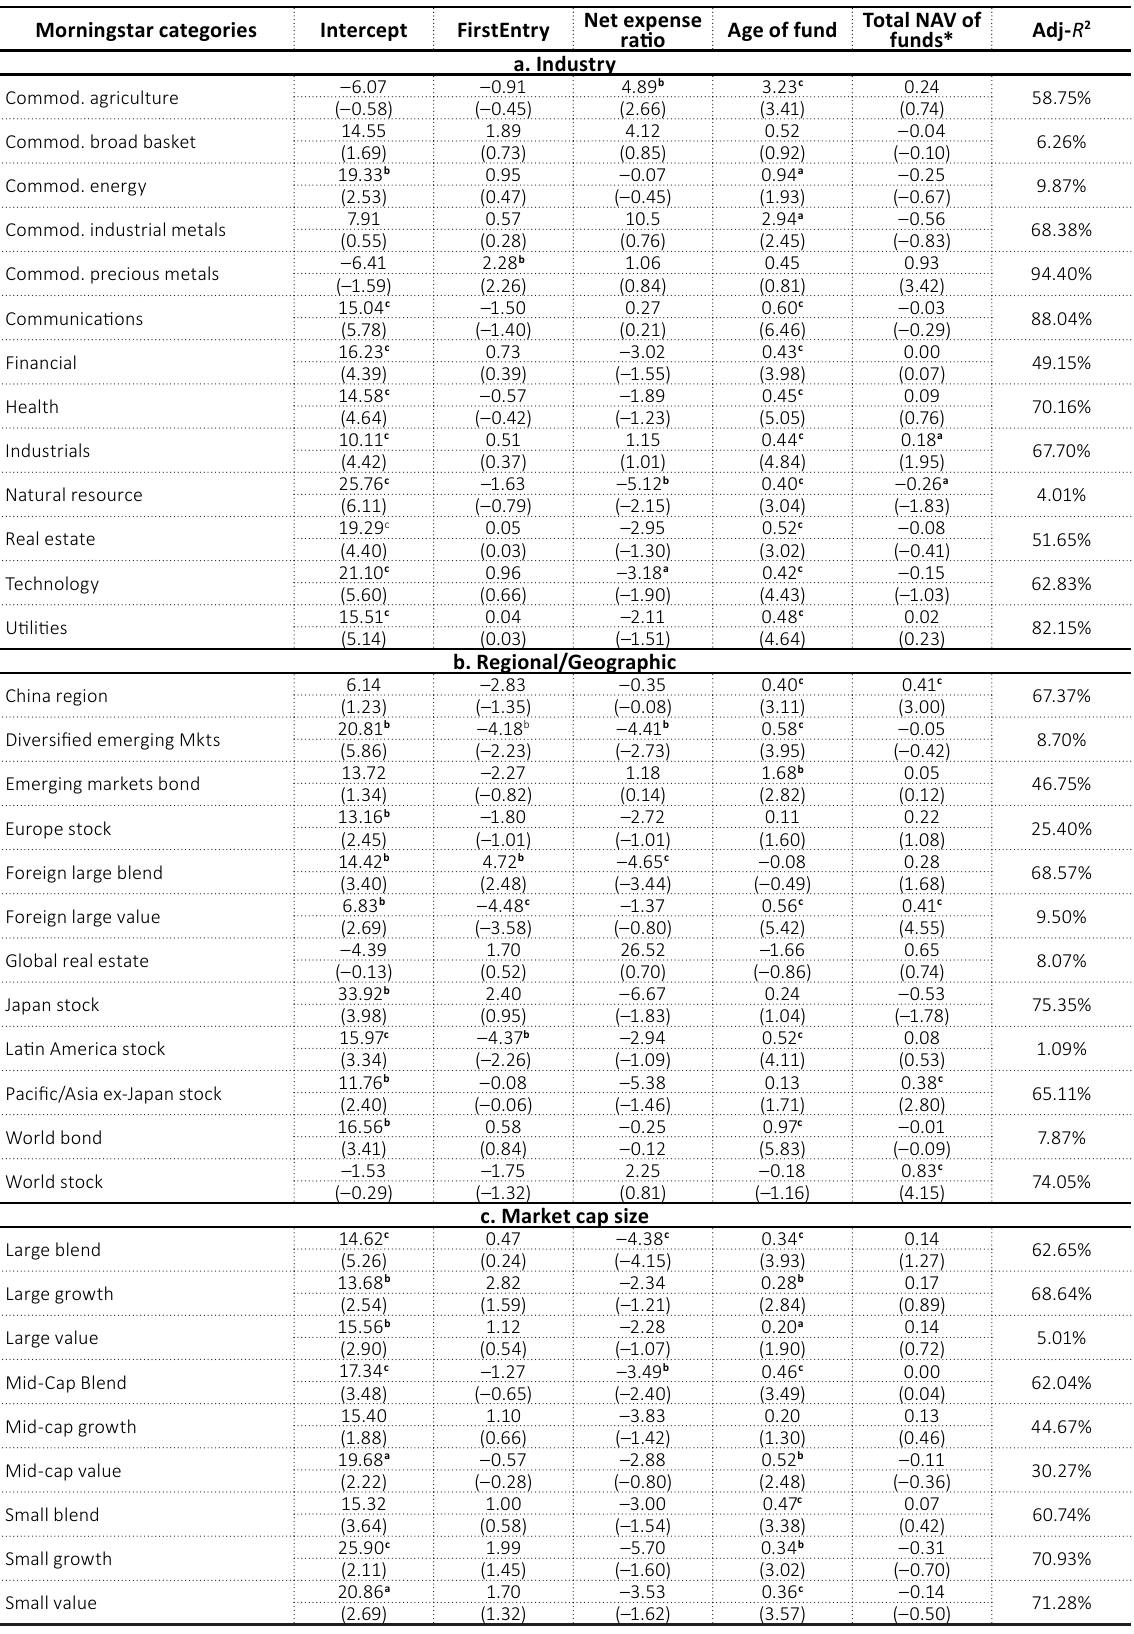
Table 4. Regression of net asset value (NAV) on FirstEntry, net expense ratio, age of fund, total NAV